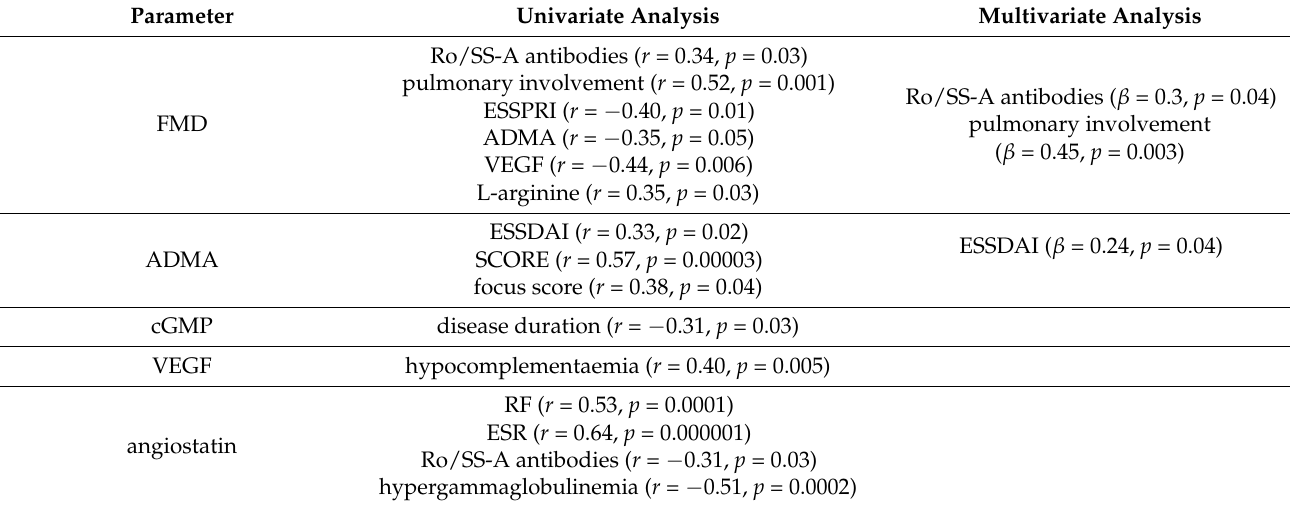
Table 3. Disease-specific variables associated with FMD and biomarkers levels.